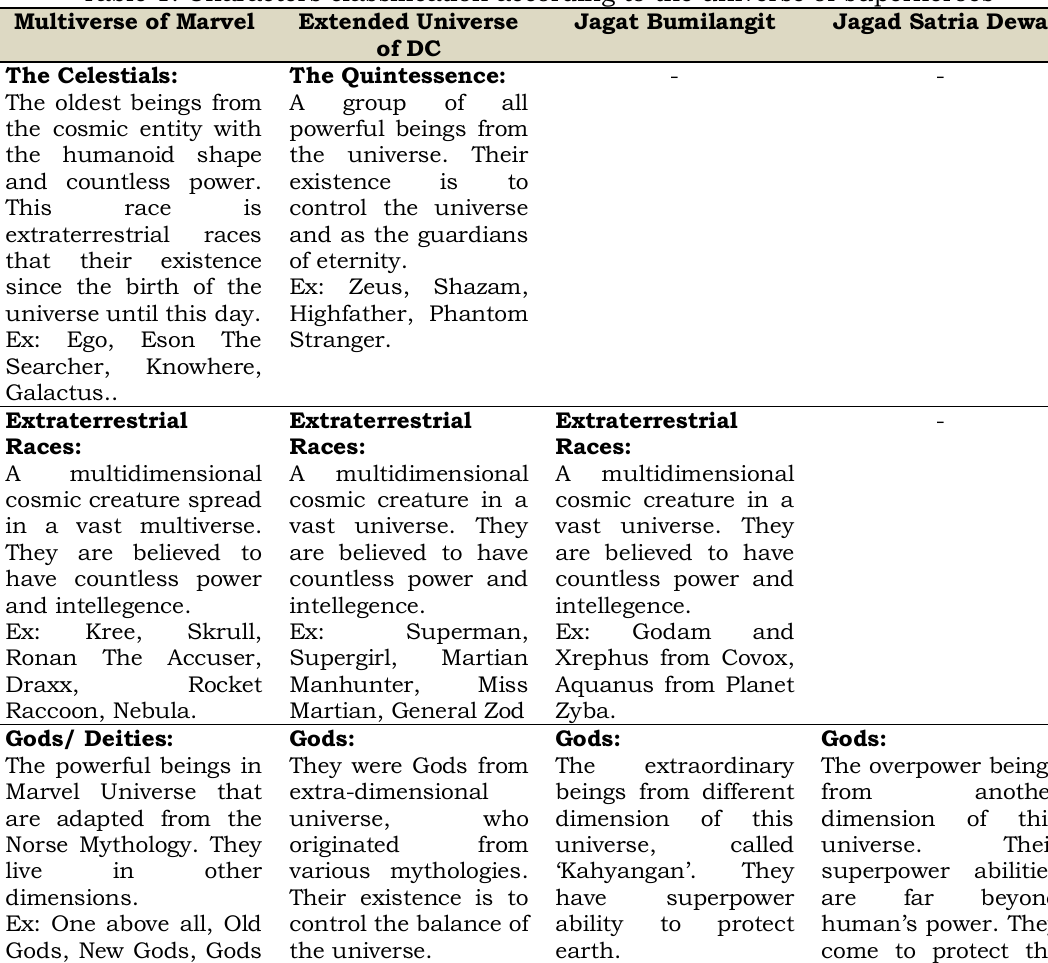
Table 1. Characters classification according to the universe of superheroes Multiverse of Marvel Extended Universe of